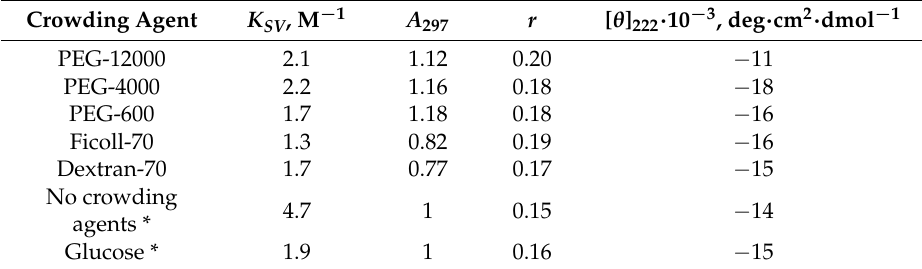
Table 1. Some spectroscopic characteristics of GGBP in crowding milieu.